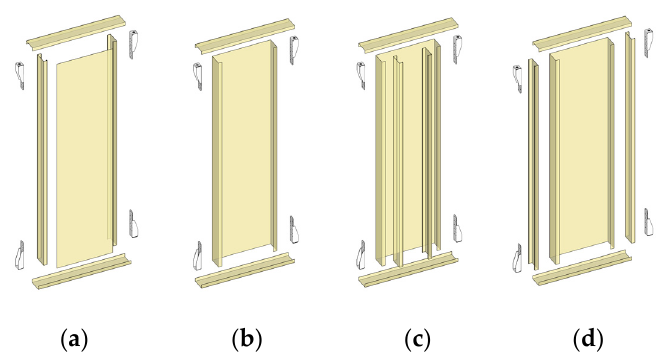
Figure 3. Specimen components: ( a ) Steel-sheathed panel, ( b ) Integrated panel, ( c ) Integrated panel-inner stud, ( d ) Integrated panel-outer stud.